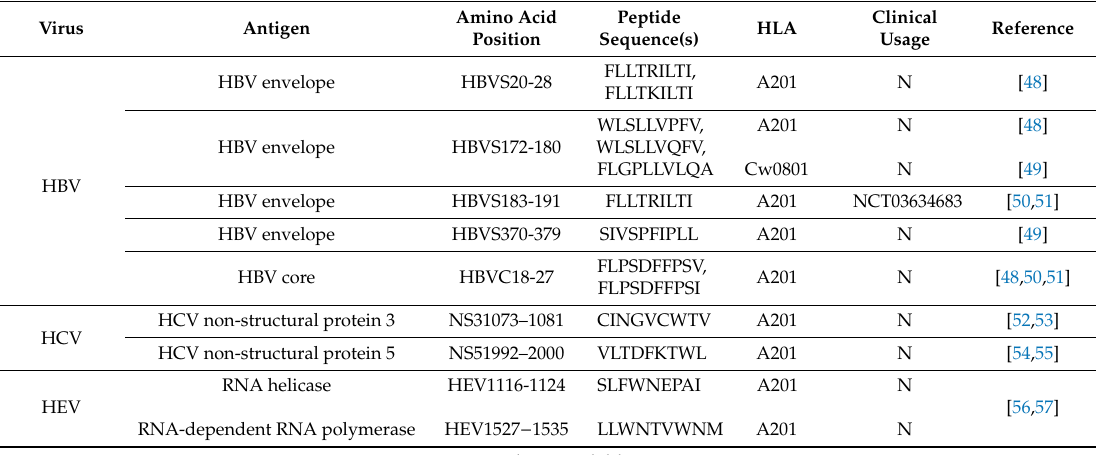
Table 1. Hepatitis virus-specific T cell receptors (TCRs) and their targets. HBV, HCV, and HEV: hepatitis B, C, and E